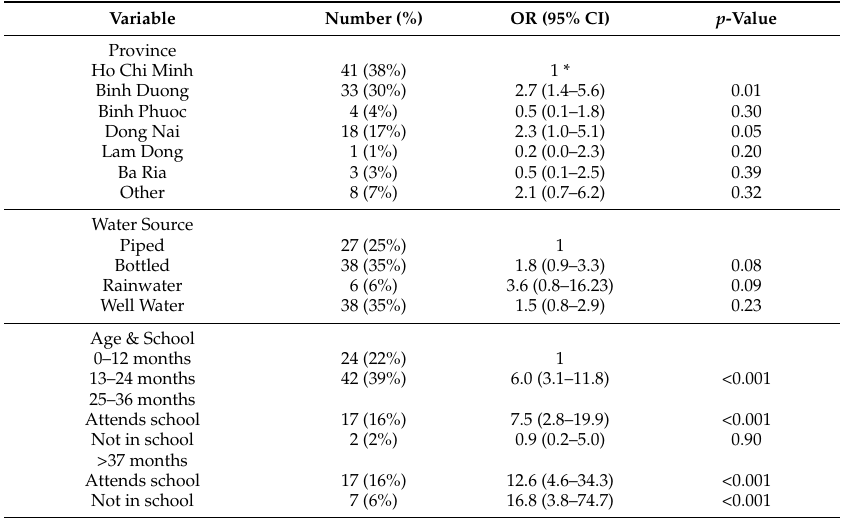
Table 5. Odds of higher BLLs (>5 µ g/dL, n = 109) by multivariate